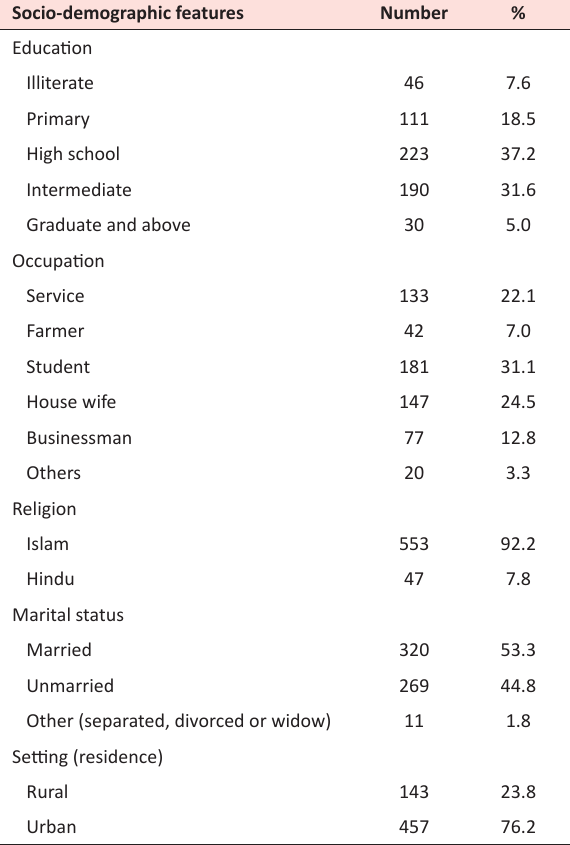
Table 2. Other socio-demographic features of the poisoning cases (n = 600)